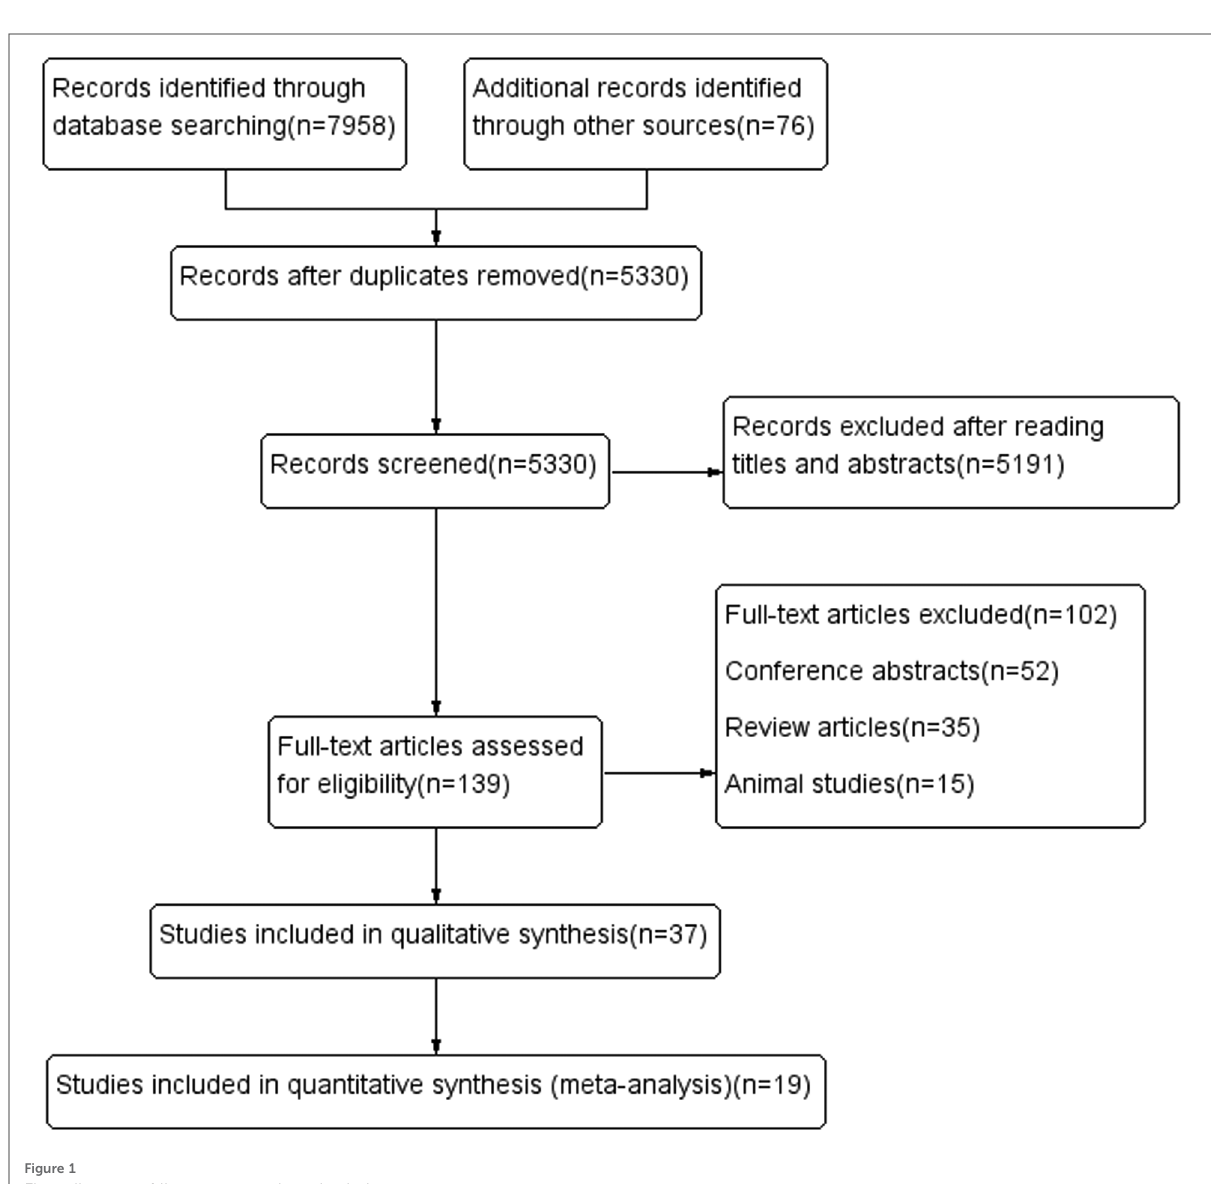
Figure 1 Flow diagram of literature search and selction